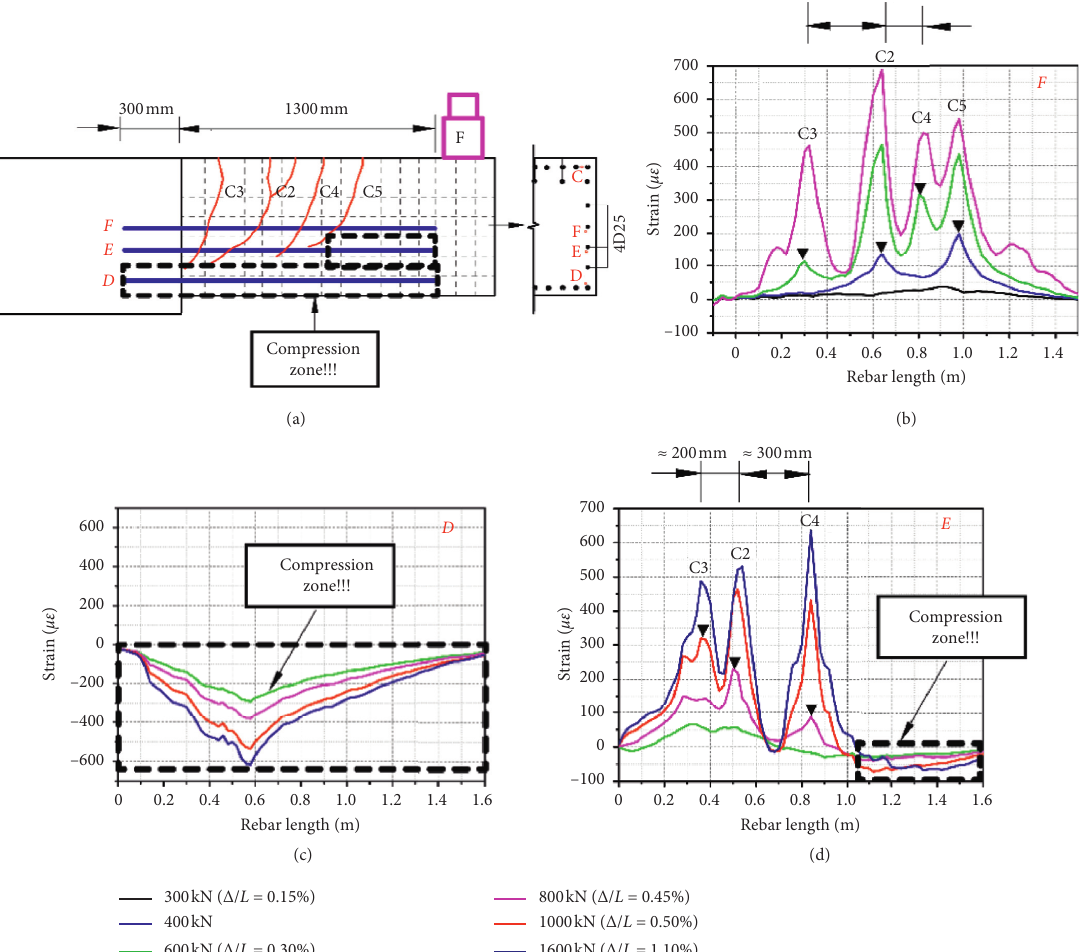
Figure 10: The damage status on lateral side at 1.1% drift (a) and strain profiles measured on side steel bars D, E, and F at drift levels below 1.1%